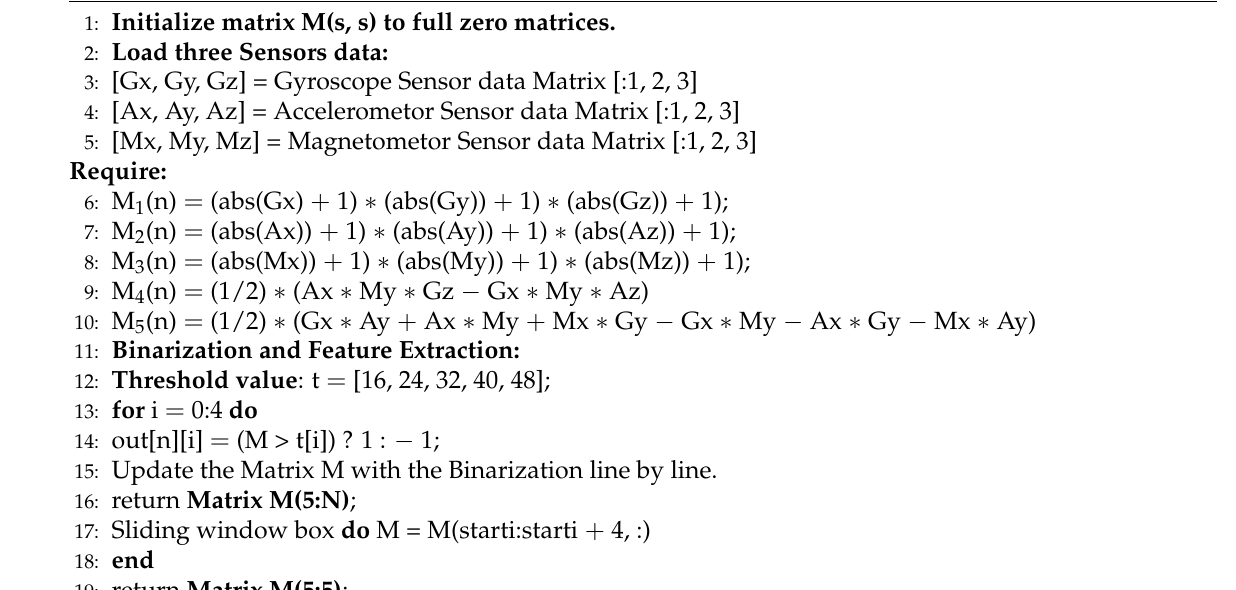
Algorithm 1 Sensor data feature extraction and binary